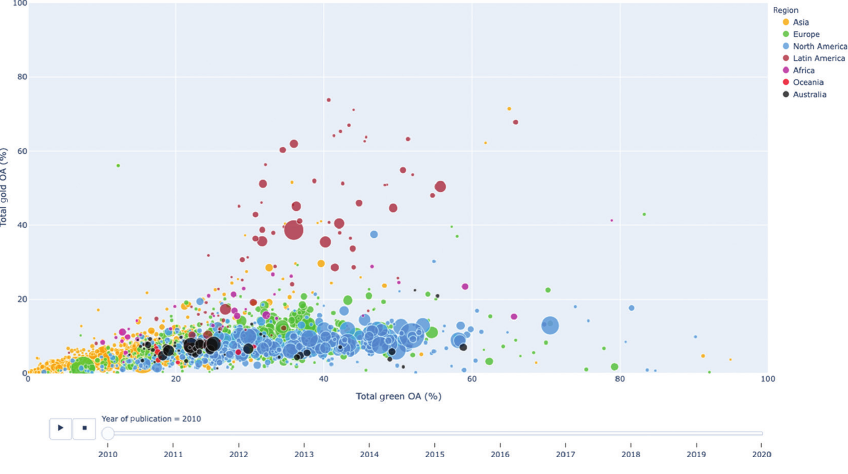
Fig. 1: Publisher-mediated OA (Gold) vs repository-mediated OA (Green) research output by institution since 2010. Each point plotted is a university, with size indicating the number of outputs. Colour indicates the region. Data sources: Crossref, Unpaywall, Microsoft Academic. Analysis and image: Curtin Open Knowledge Initiative.